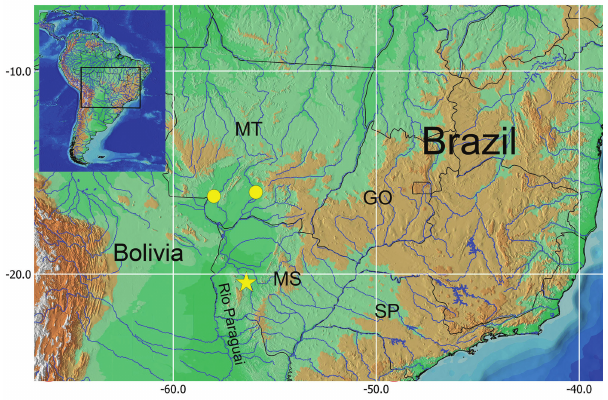
Fig. 3. Geographic distribution of Microglanis leniceae in states of Mato Grosso (MT) and Mato Grosso do Sul (MS) (yellow star = type locality). Brazilian states acronyms: GO = Goiás; SP = São